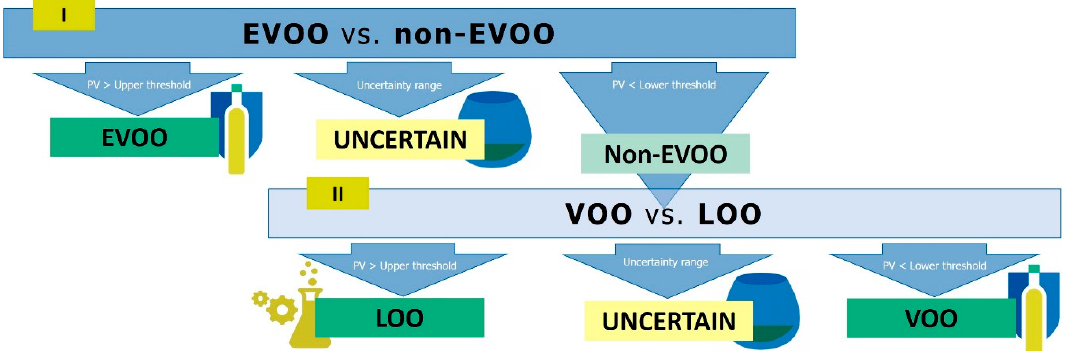
Figure 1. Flow chart of the two-step hierarchical classification strategy to classify virgin olive oils into their quality grades: extra-virgin (EVOO), virgin (VOO) and lampante (LOO) olive oils. PV: predicted values.